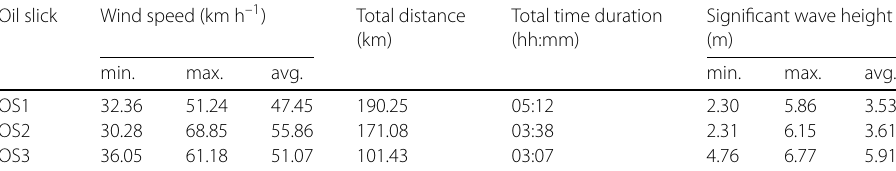
Table 4 The corresponding information of the three oil slicks on 4 January 2019, a day with the tropical cyclone Pabuk Oil